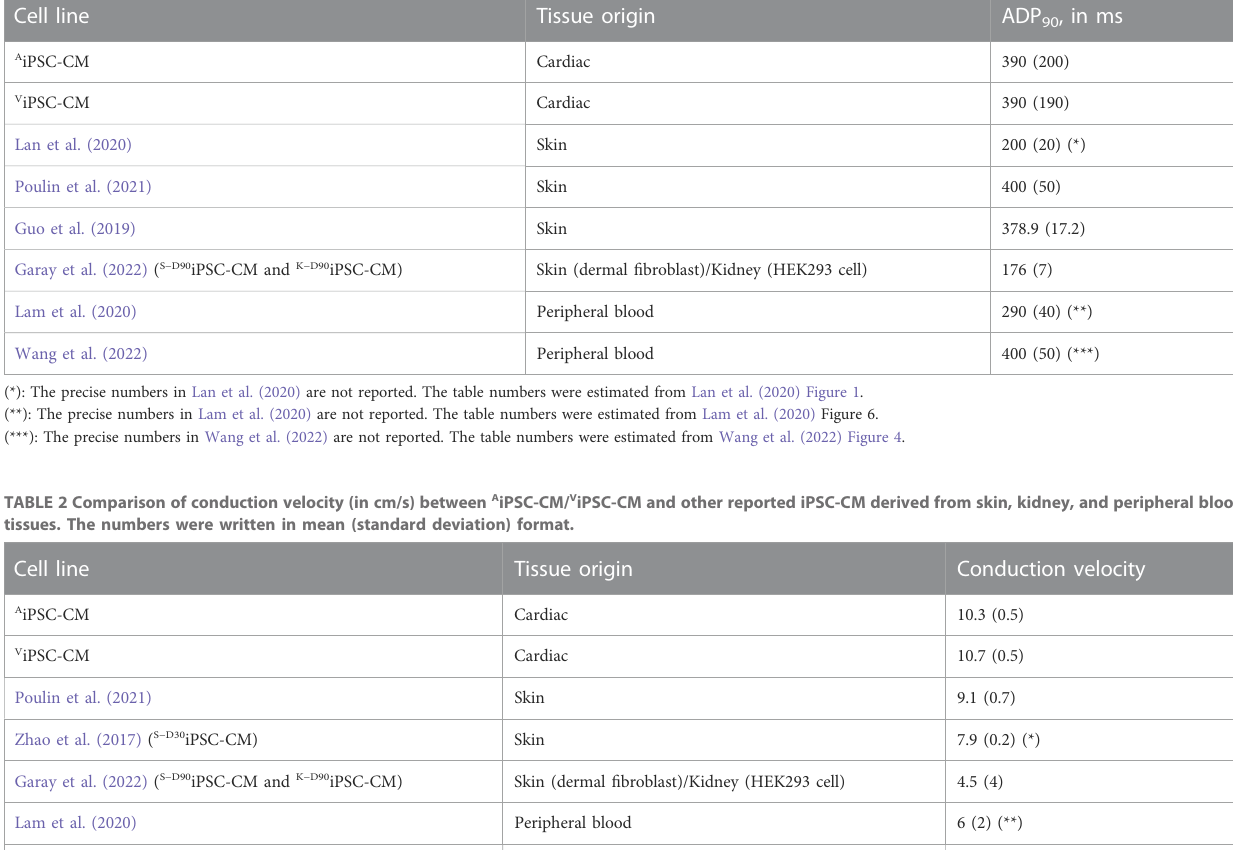
TABLE 1 Comparison of ADP 90 (in ms) between A iPSC-CM/ V iPSC-CM and other reported iPSC-CM derived from skin, kidney, and peripheral blood tissues. The numbers were written in mean (standard deviation) format. Cell line